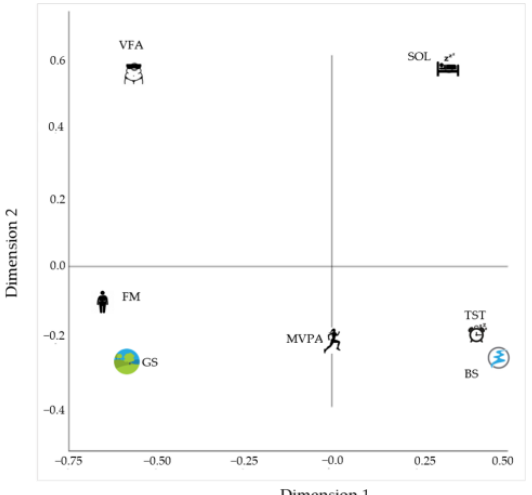
Figure 3. Component loadings. The plot of centroids, labeled by categories, is presented in Figure 4. The results show that living within 300 m of green spaces was associated with recommended levels of sleep onset latency (SOL_R) and lower levels of fat mass (FM_L). Women who lived closer to green spaces tended to have a shorter time transitioning from wakefulness to sleep